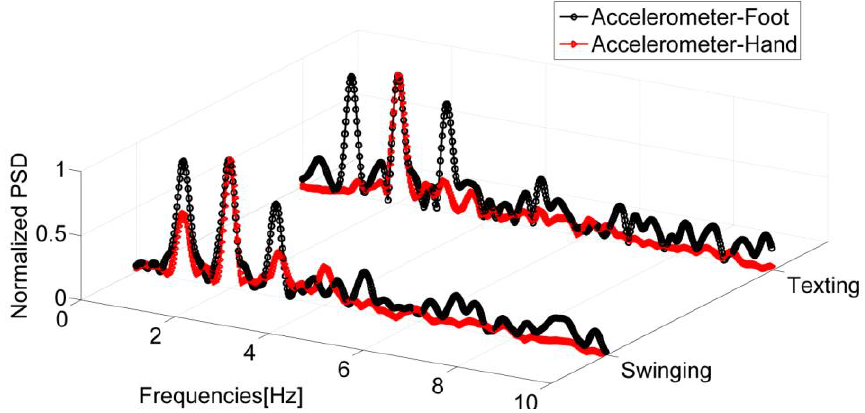
Figure 4. Normalized PSD of the accelerations sensed by the foot mounted sensor and the one in the swinging and texting hand. For both motion modes, the strongest frequency is coupled with the step event.